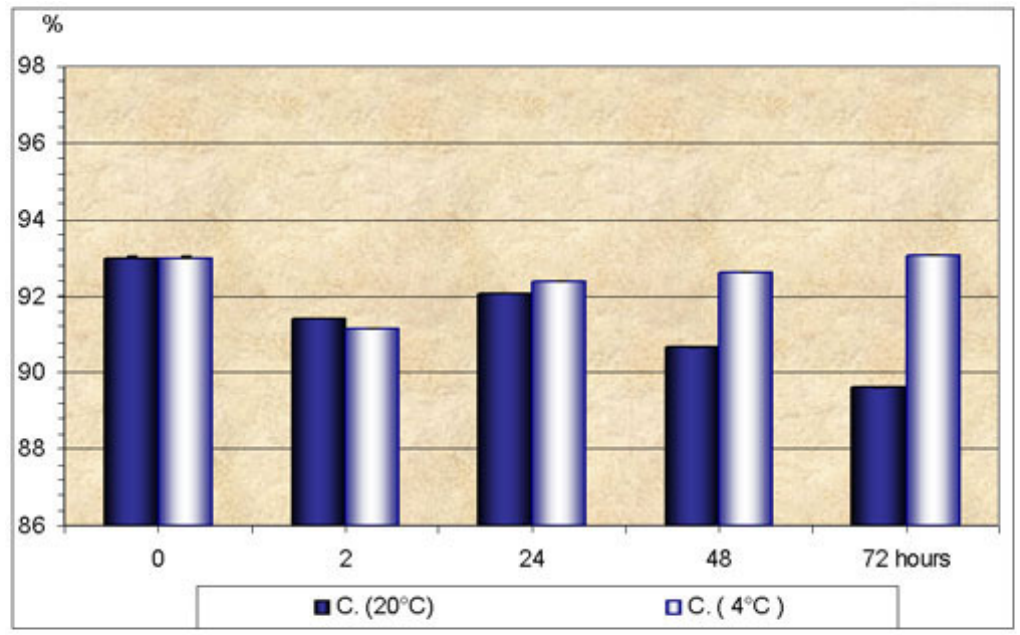
FIGURE 2B. The time-dependent changes of seed dry weight in nontreated DW in cold and warm conditions. On abscissa, the time (in hours) of seed incubation; on ordinates, percent of seed dry weight changes comparing to its wet weight 0 .